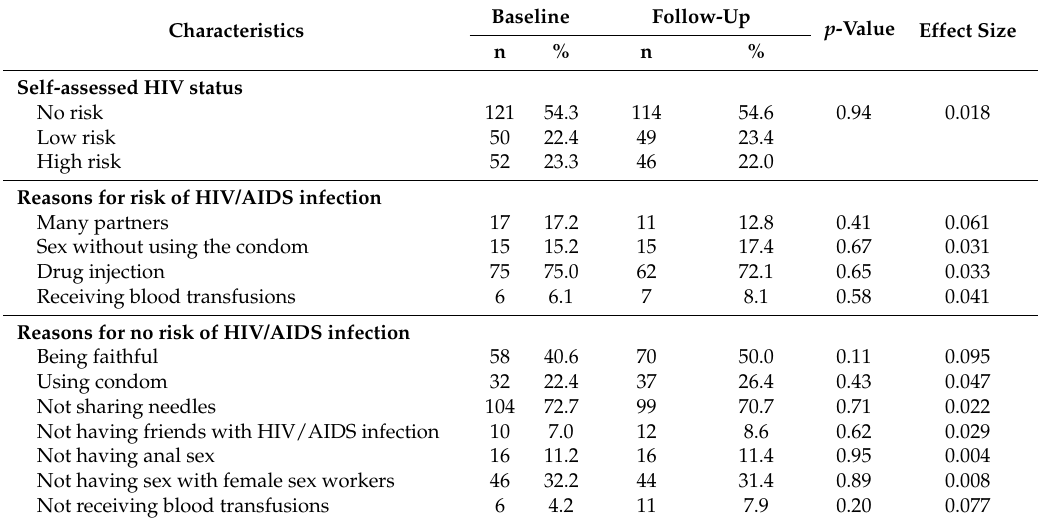
Table 2. Change in perceived HIV risk among methadone maintenance treatment